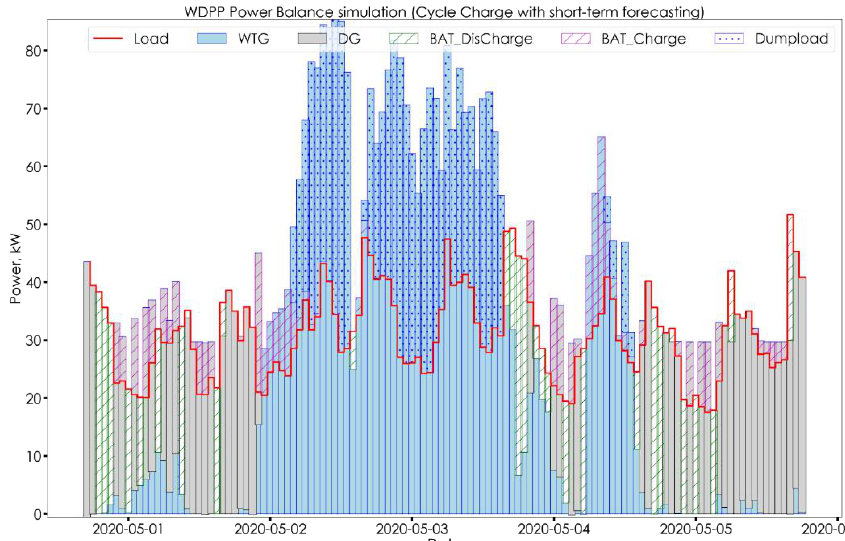
Figure 6. Power balance under the load following mode (SCADA measurements).